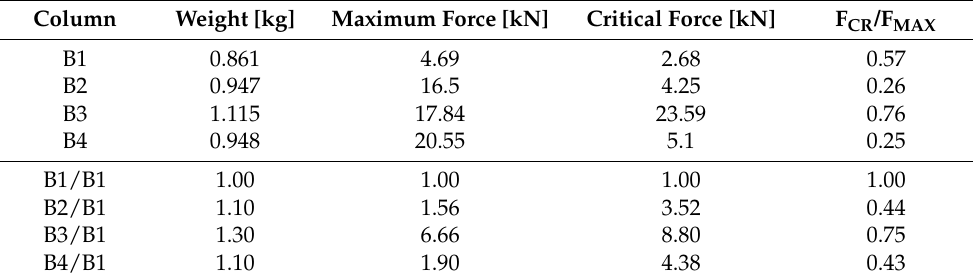
Table 10. Comparison of column weights with values of resistance and critical forces obtained from strain gauge